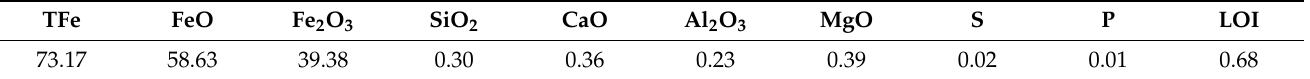
Table 2. Chemical composition of iron oxide scale, wt %.